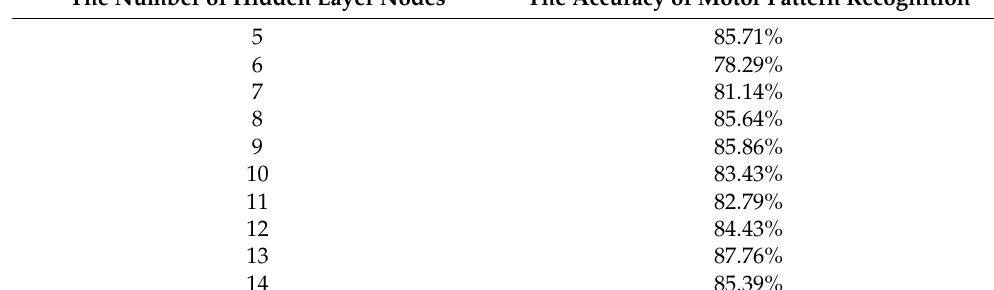
Table 3. Accuracy of motor pattern recognition.